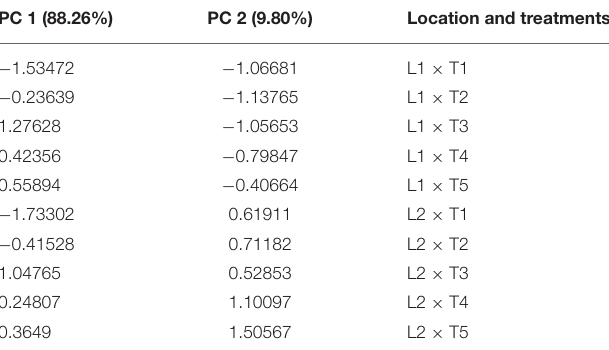
TABLE 7 | Factor loading and values of percentage variance for different treatments and locations obtained in PCA analysis. PC 1 (88.26%) PC 2